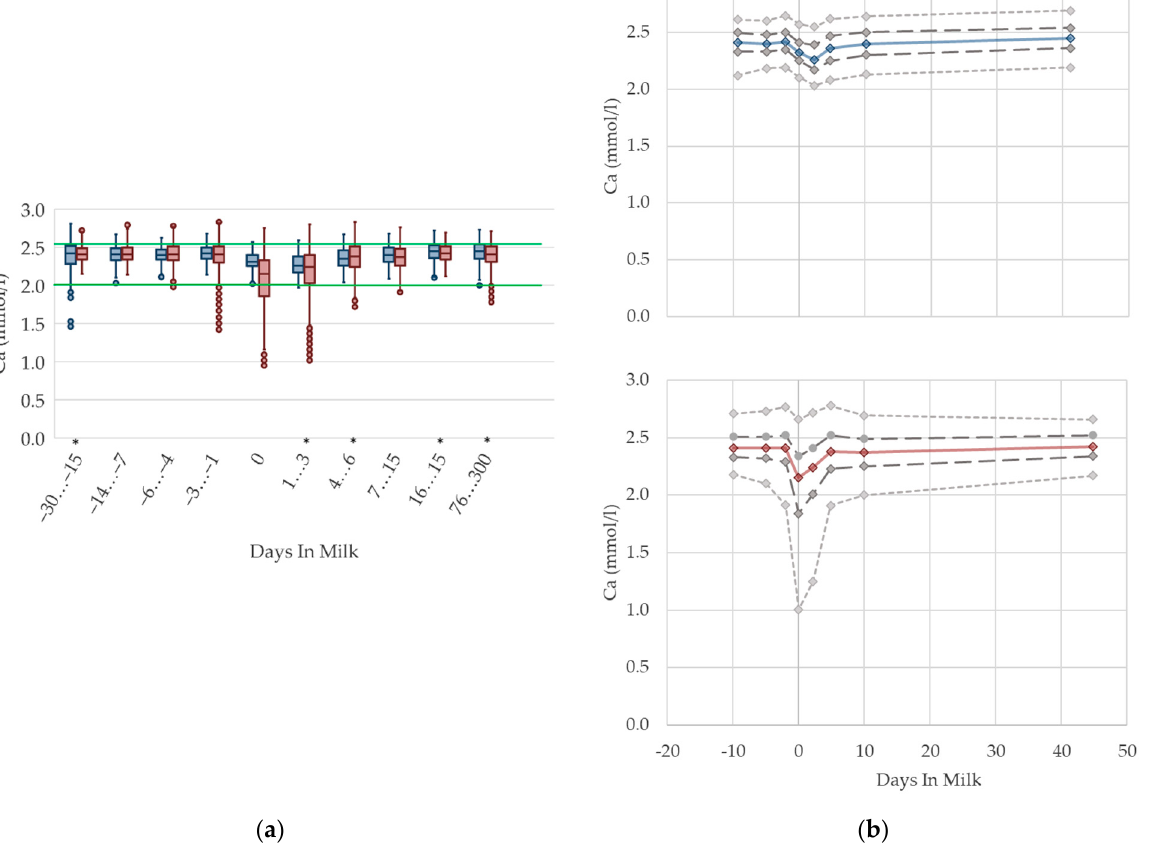
Figure 9. Serum concentrations of calcium (Ca) in primiparous (blue) and in multiparous (red) cows ( a ) in 10 classes between 30 days prepartum to 300 days postpartum (boxplots), green continuous lines represent the reference values according to Fürll [23], asterisk indicates significant differences regarding parity within DIM class; and ( b ) in 8 classes from 10 days prepartum to 40 days postpartum (median—continuous line; 1st and 3rd quartile—dashed lines; percentile 5 and 95—dotted lines).